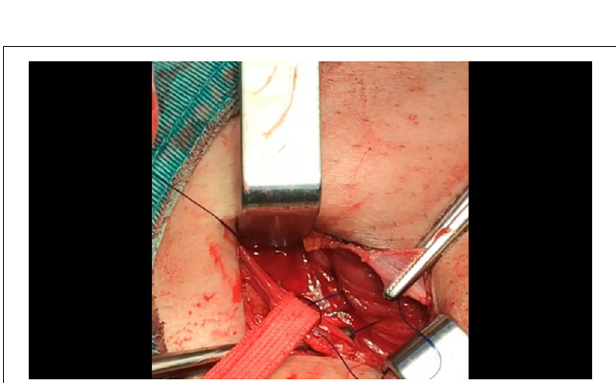
FIGURE 5 | After reconstructing the internal ring (with the mesh already embedded in the preperitoneal space), the same line of suturing should be threaded back toward the external ring to create a continuous